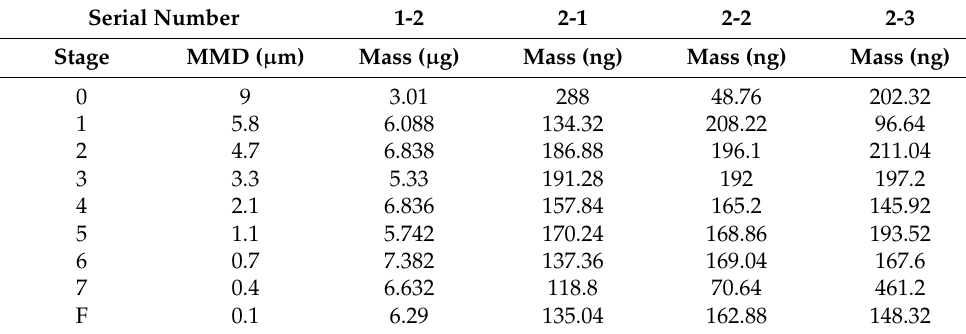
Table 6. Particle size distribution data of cerium aerosol.